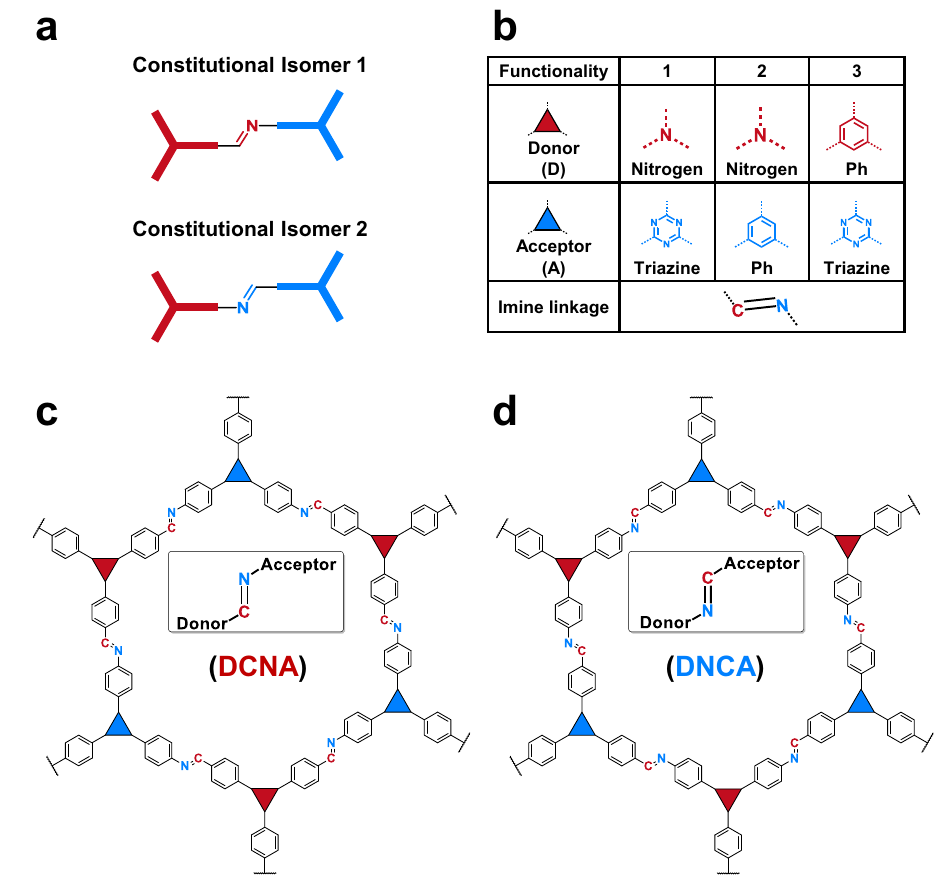
Fig. 1 | Chemical structures of the isomeric COFs. a Constitutional isomerism of theiminelinkage.Theredandbluetrianglesrepresentdonororacceptormoieties.